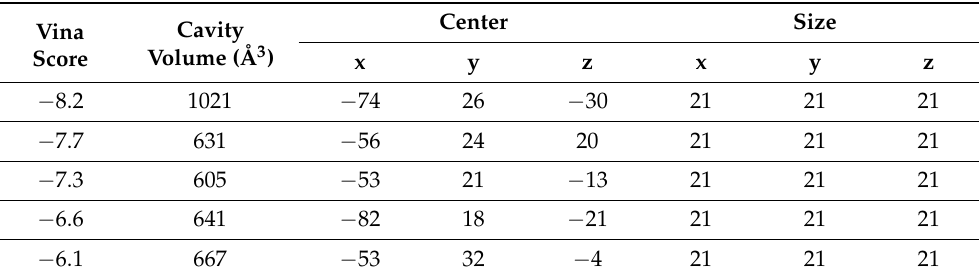
Table 5. Binding mode and the related cavity size based on the results of CB-Dock for quercetin and the receptor of